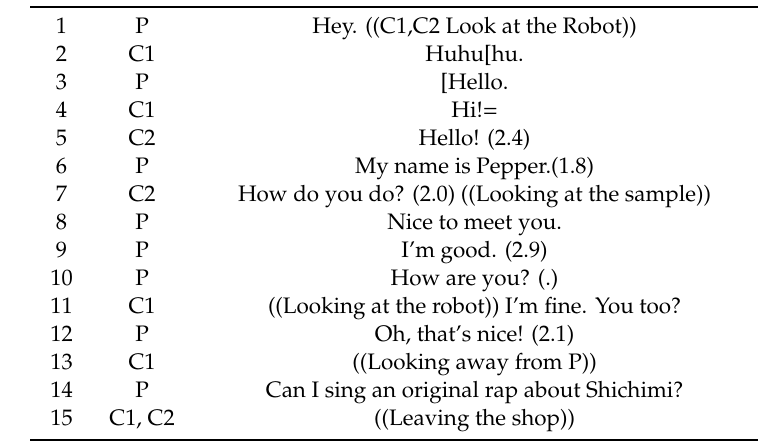
Table 10. Conversation in which the robot could not continue the conversation without the state-transition model (17 April 2019).